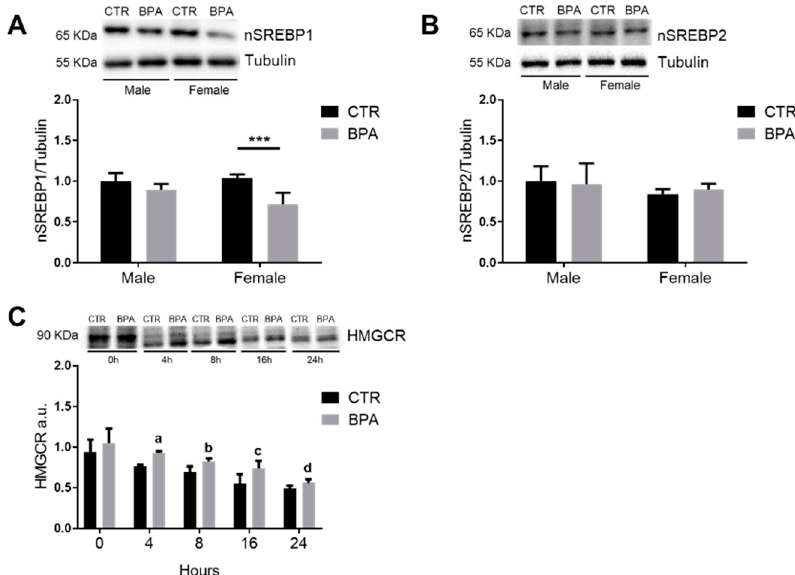
Figure 4. Effects of prenatal exposition to 2.5 µg/kg/day of BPA on SREBPs activation and HMGCR degradation rate in fetal livers of male and female rats. The figure shows the typical Western blot and the densitometric analysis of total HMGCR ( A ) and total ACC ( B ). Tubulin was used to normalize protein loading. Values are expressed as mean ± SD, n = 6 for each experimental group. Differences were considered as significant at p < 0.05 and were analyzed with two-way ANOVA, followed by Tukey post hoc test. *** = p < 0.001 vs. CTR female. ( C ) Representative Western blot and densitometric analysis of in vitro HMGCR degradation assay in female fetuses (for details see the main text). Data were analyzed with unpaired Student’s t test, and differences between each time point were considered as significant at p < 0.05. a = p < 0.001 vs. CTR 4 h; b = p < 0.5 vs. CTR 8 h; c = p < 0.5 vs. CTR 16 h; d = p < 0.5 vs. CTR 24 h.